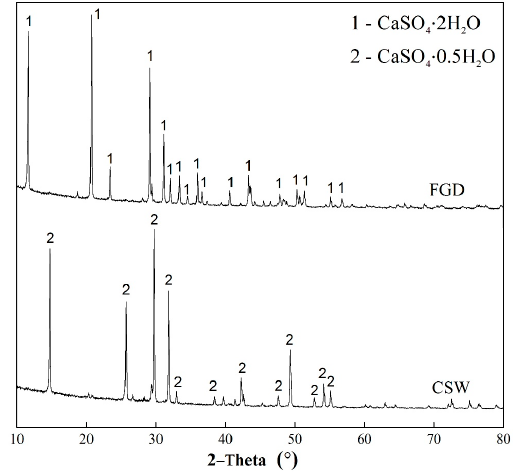
Figure 2. X-ray diffraction patterns of FGD gypsum and CSHW derived from FGD gypsum by the hydrothermal synthesis.